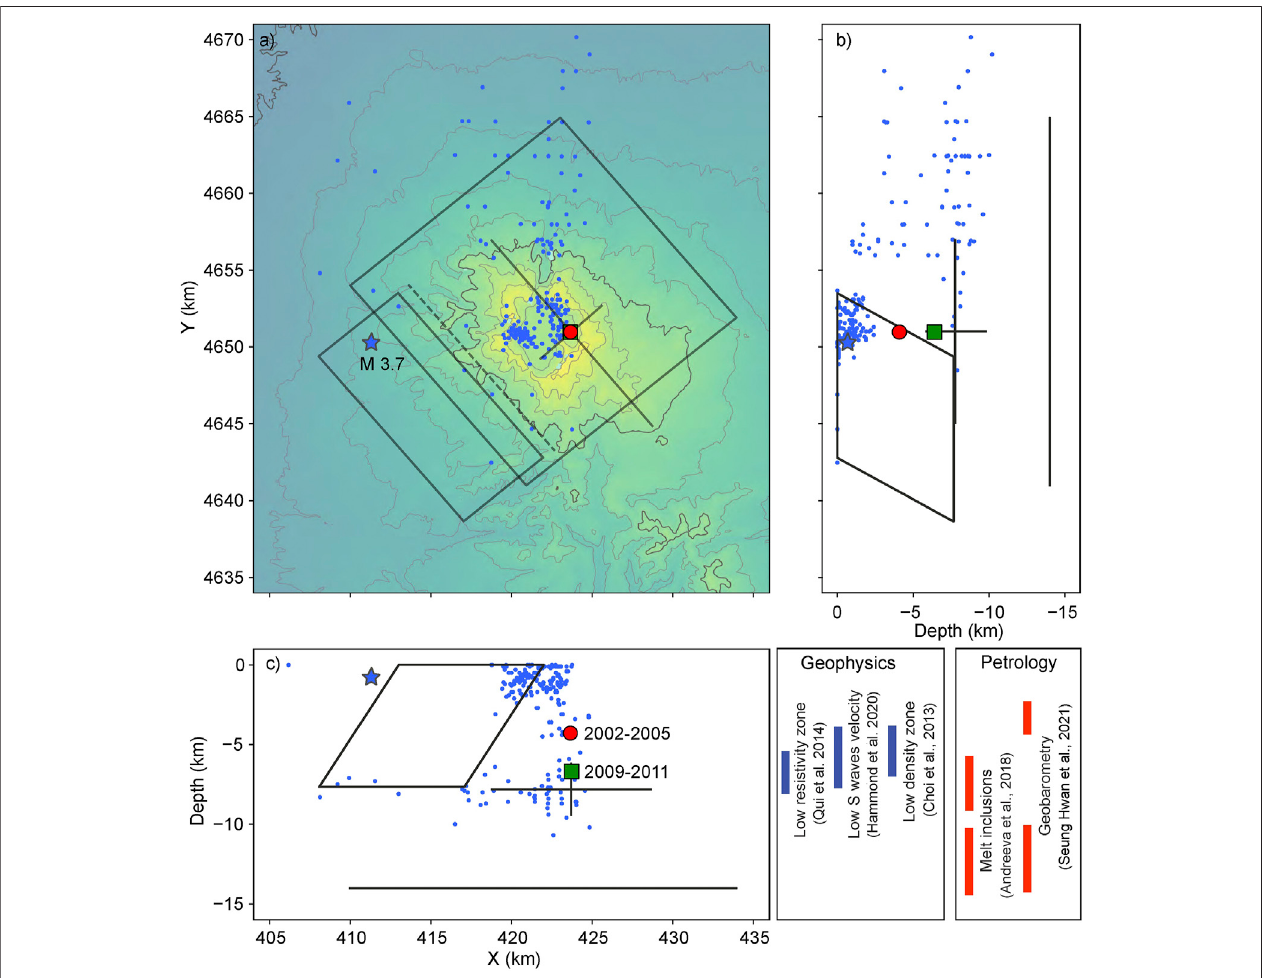
FIGURE 6 | 3D view of seismicity during 2002 – 2006 (blue dots, the star is the M 3.7 of October 22, 2006) and the active deformation system at Changbaishan at different epochs; (A) plane view, (B) depth vs North coordinate, and (C) East coordinate vs depth. In dark grey are reported the sources retrieved by ALOS2 data for 2018 – 2020. The spheroid is indicated with its axes. The red circle is the location of the 2002 – 2006 source, while the location of the 2009 – 2011 is reported with green square. UTM-WGS84 Zone 52N used as projected coordinates. Topography contour in (A) every 200 m, with bold line at 1,000 m. The inferred depth of magma storage zones from available geophysical and petrological data are reported in the bottom right